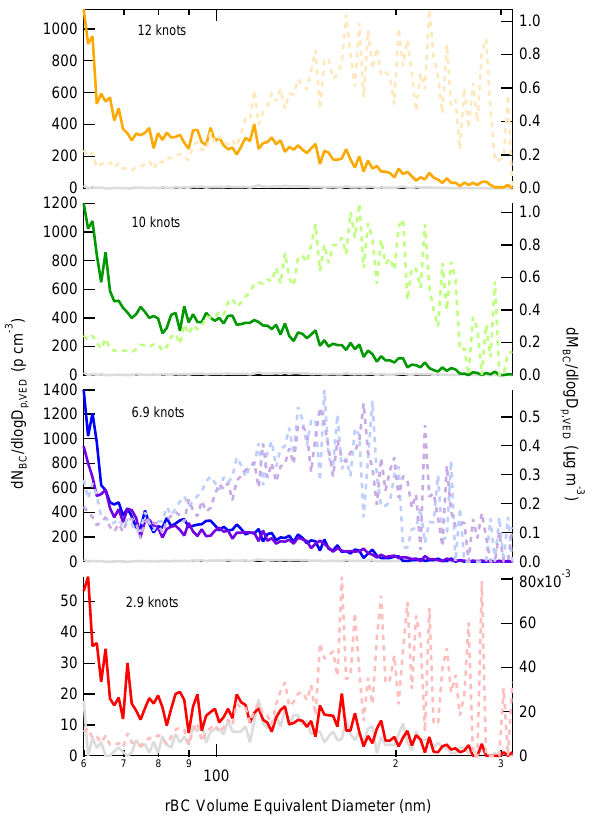
Fig. 4. Number-weighted (left axis and solid lines) and mass- weighted (right axis and dashed lines) size distributions for the rBC component of particles for each plume intercept, averaged over the entire plume. The number-weighted distributions for background (outside of plume) particles are shown as the grey traces in all pan- els. For all but the 2.9knots plume the observed size distribution is well above the background. The speed of the R/V Miller Freeman corresponding to each plume is indicated on each